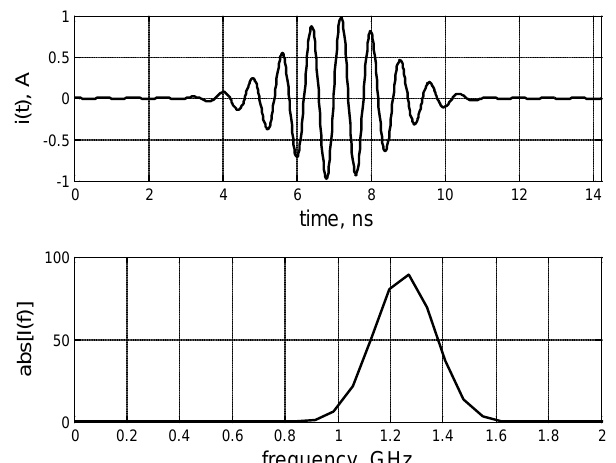
Figure 5: Transient p lot o f th e c onsidered e xcitation c urrent i ( t ) and its frequency spectrum I ( f ).